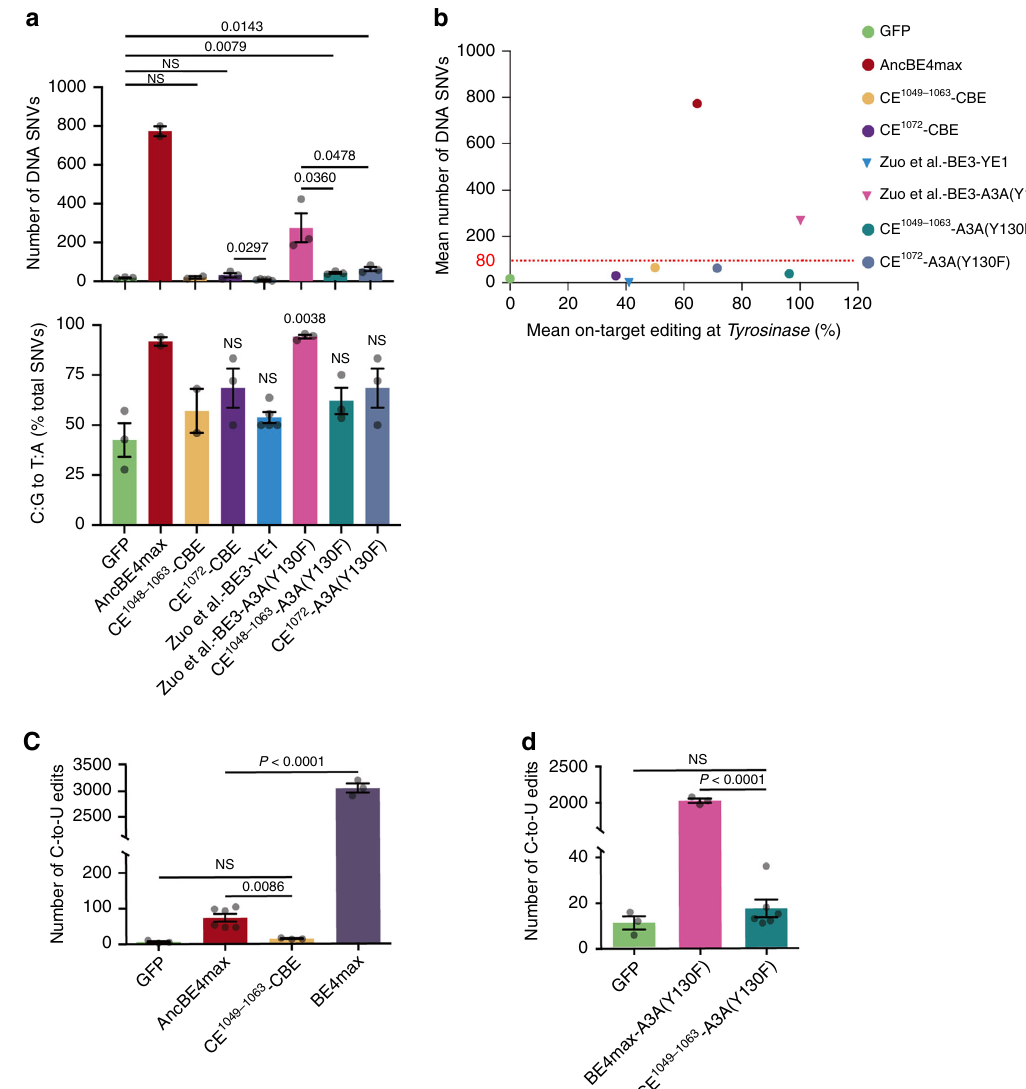
Fig. 4 Off-target effects of CE-CBEs. a , b , GOTI assay detecting off-target SNVs at the mouse genome. The bar graphs ( a ) display the total numbers of SNVs (top) and the proportions of the relevant subsets (bottom), while the scatter plot ( b ) displays the total SNV numbers and the on-target editing rates of the editors. The data were all generated in this study except for YE1-BE3 and BE3-A3A(Y130F), which were from refs. 5,10 , respectively. Values in a , b are mean ± s.e.m from two to three biological replicates as indicated by the dots. c , d RNA-seq analysis of off-target effects at the transcriptome for CE-CBE ( c ) and CE-A3A ( d ). Values in c , d are mean ± s.e.m for three or six biological replicates as indicated by the dots. NS not signi fi